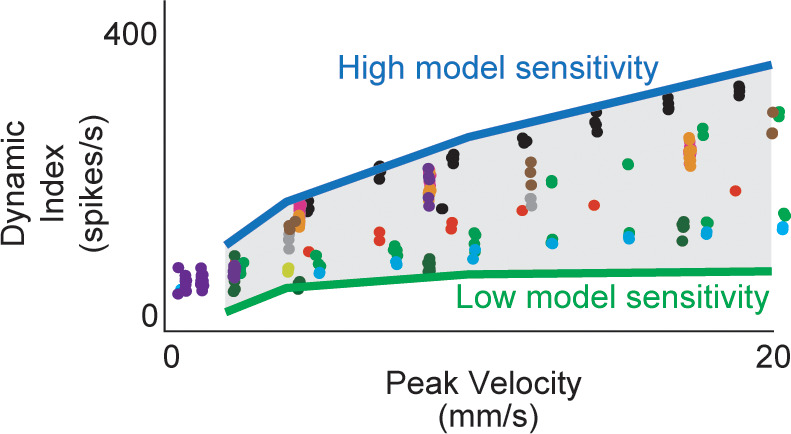
Estimated muscle fiber force model predicts inter-afferent variability of healthy afferent firing properties across perturbation velocity and acceleration.(A) Same dynamic index data shown in Figure 3-2 (colored dots) with predicted range of dynamic indices from model (gray shaded area). Nominal simulations were performed with the same force and yank model sensitivities for four stretch trials (2, 4, 10, 20 mm/s) from the same animal. Model parameter sweeps were performed for force and yank sensitivities for each of the four trials from 0.1 to 5 times the nominal value for each parameter. Green line represents the minimum dynamic indices from each of the four parameter sweeps from trials for which there was a spiking response (usually corresponding to low force and yank sensitivities). Blue line represents maximum dynamic indices from each of the four parameter sweeps (usually corresponding to high force and yank sensitivities). Gray shaded area represents plausible space of simulated dynamic index.